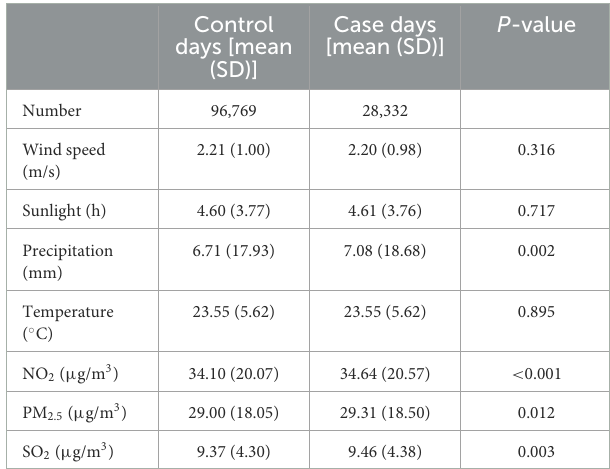
TABLE 2 Distribution of weather and pollutant concentrations for case days and control days in Guangzhou, China,